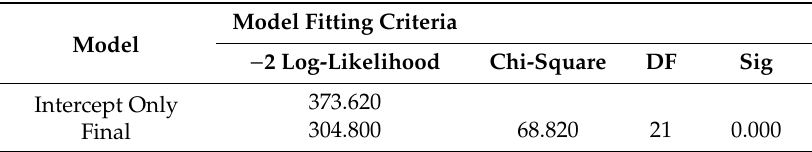
Table 5. Model fitting